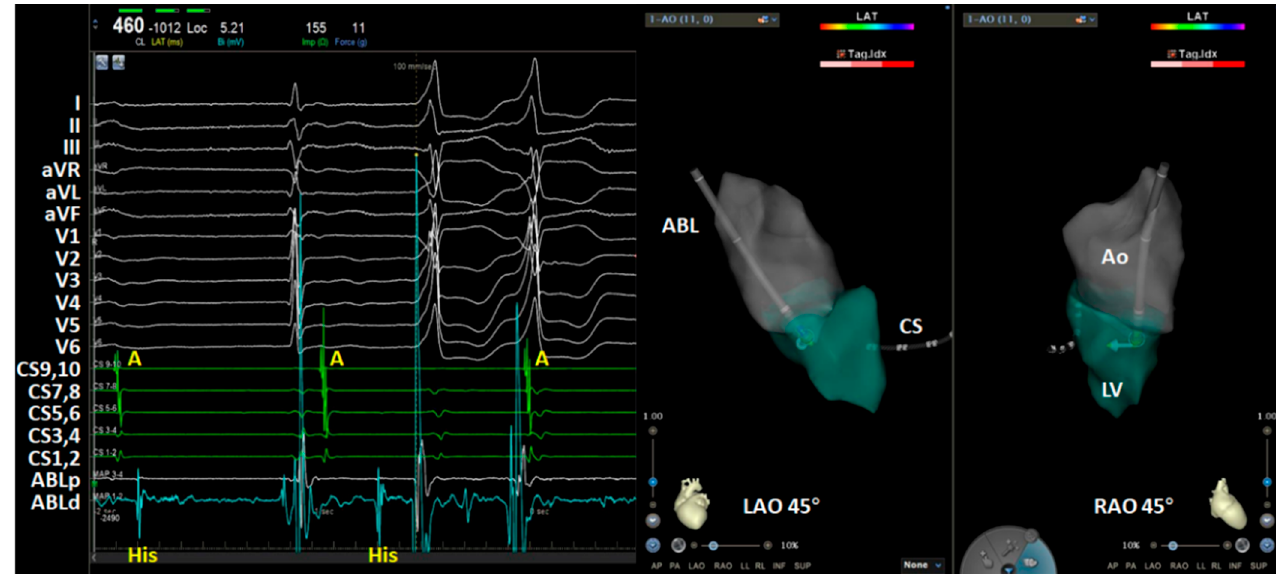
Figure 3. His potentials were recorded by the ablation catheter when the catheter was withdrawn from the left ventricle (LV). Note that the His potentials were dissociated with the atrial (A) and ventricular potentials. ABL, ablation catheter; Ao, aorta; CS, coronary sinus; LAO, left anterior oblique; RAO, right anterior oblique.